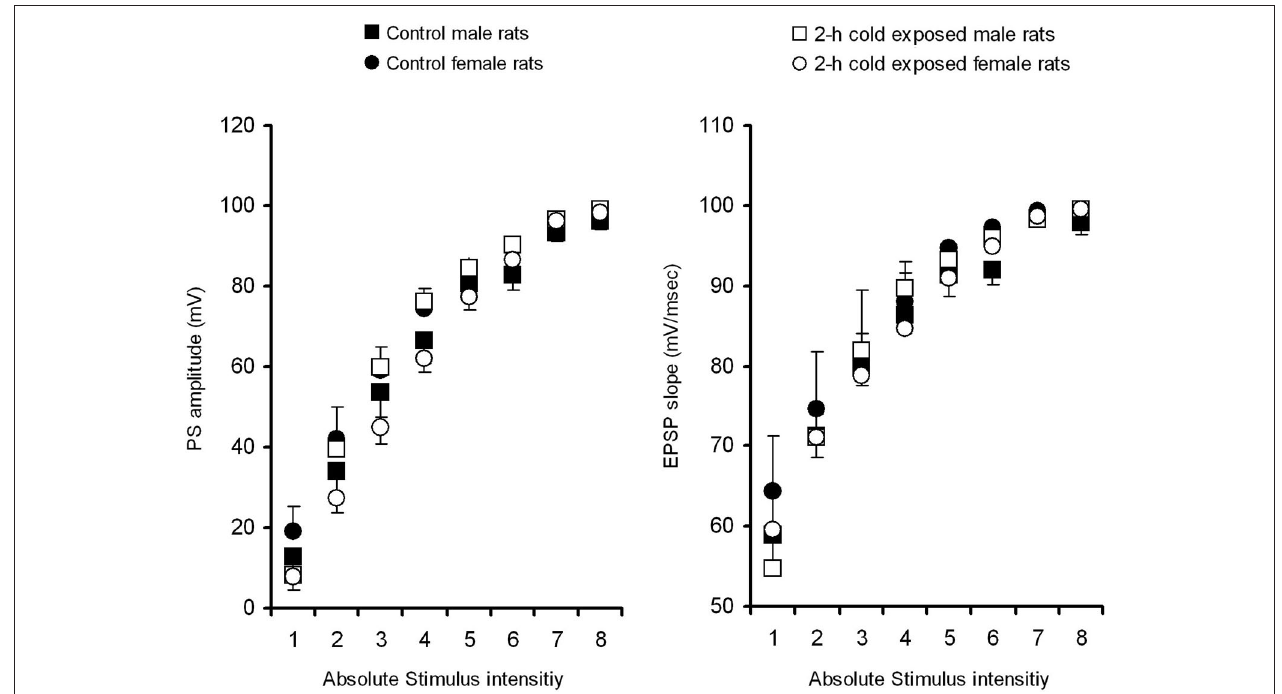
FIGURE 3 | Absolute input–output curves of the population spike (PS) amplitude (left) and field excitatory postsynaptic potential (EPSP) slope (right) in the dentate gyrus (DG) area of the control (male, black square , n = 6; female, black circle , n = 6) and intermittent cold stress (male, empty square , n = 6; female, empty circle , n = 6) groups as a function of stimulus intensity before induction of LTP . Bars are standard errors of the